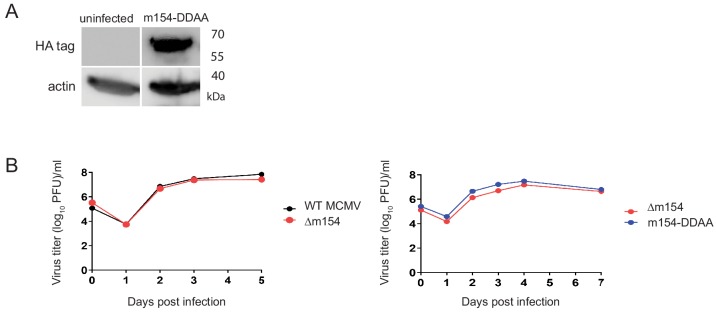
Characterization of mutated m154 expression and growth kinetics of m154-DDAA viral mutant.(A) DC2.4 cells were infected with 3 PFU/cell of m154-DDAA virus for 40 h or left uninfected. HA tag was detected in cell lysates by western blot using an anti-HA Ab followed by anti-rat POD antibody. (B) MEFs were infected with 0.1 PFU/cell with WT MCMV, ∆m154, or m154-DDAA virus. At indicated days p.i. the amount of extracellular infectious virus present in the culture supernatant was determined by standard plaque assay. Each data point represents the average of three separate cultures.